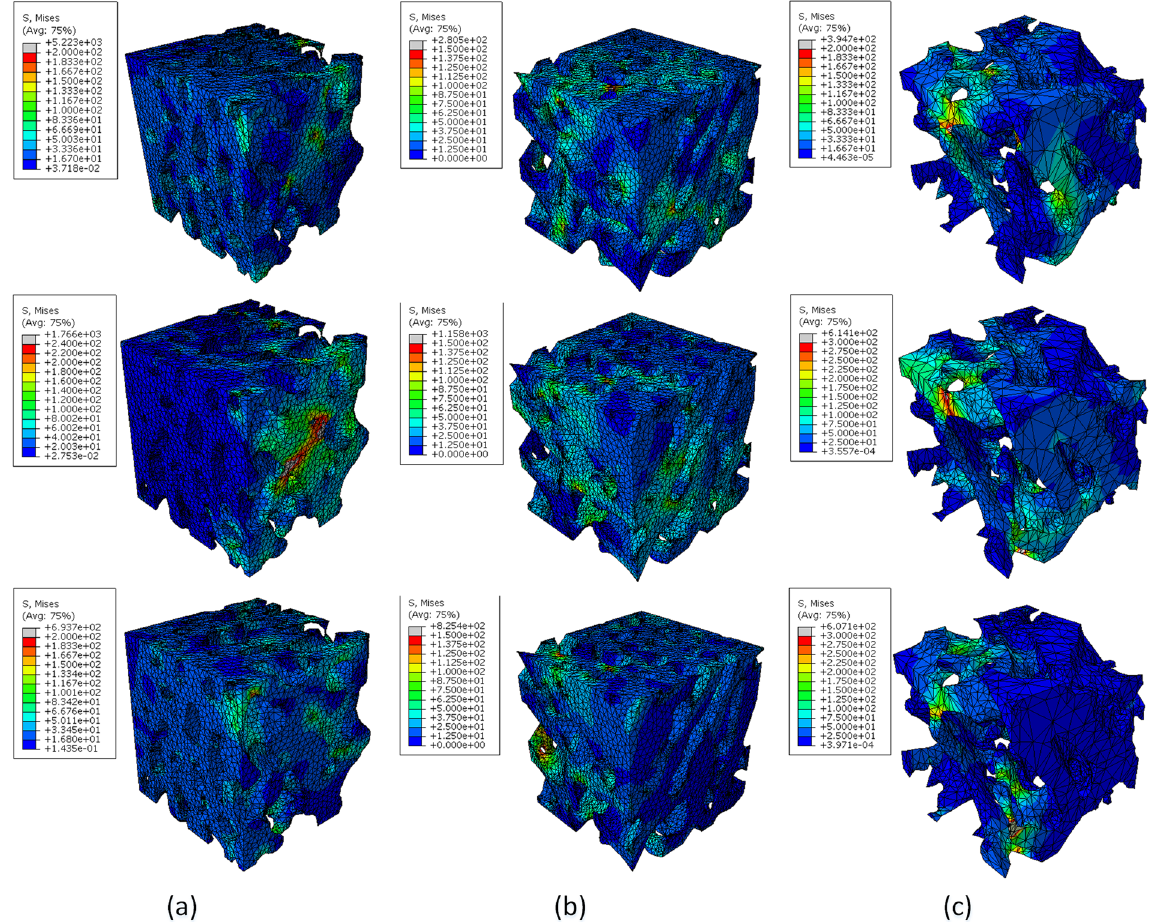
Figure 5. Von Mises stress distributions of a typical bone sample in different regions of the bone.